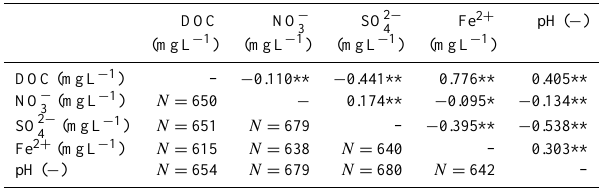
Table 3. Correlations (Pearson) among solutes in long-term data 1987–2009 (Bavarian Federal Environmental Authority, 2010, un- published).